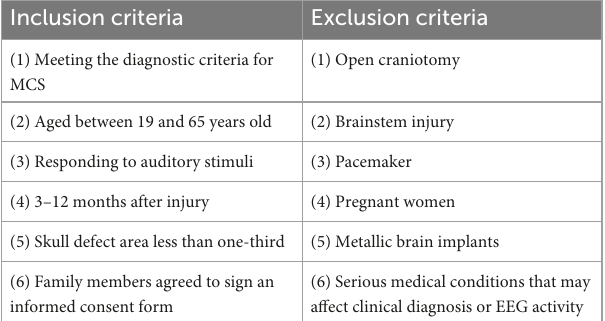
Inclusion criteria Exclusion